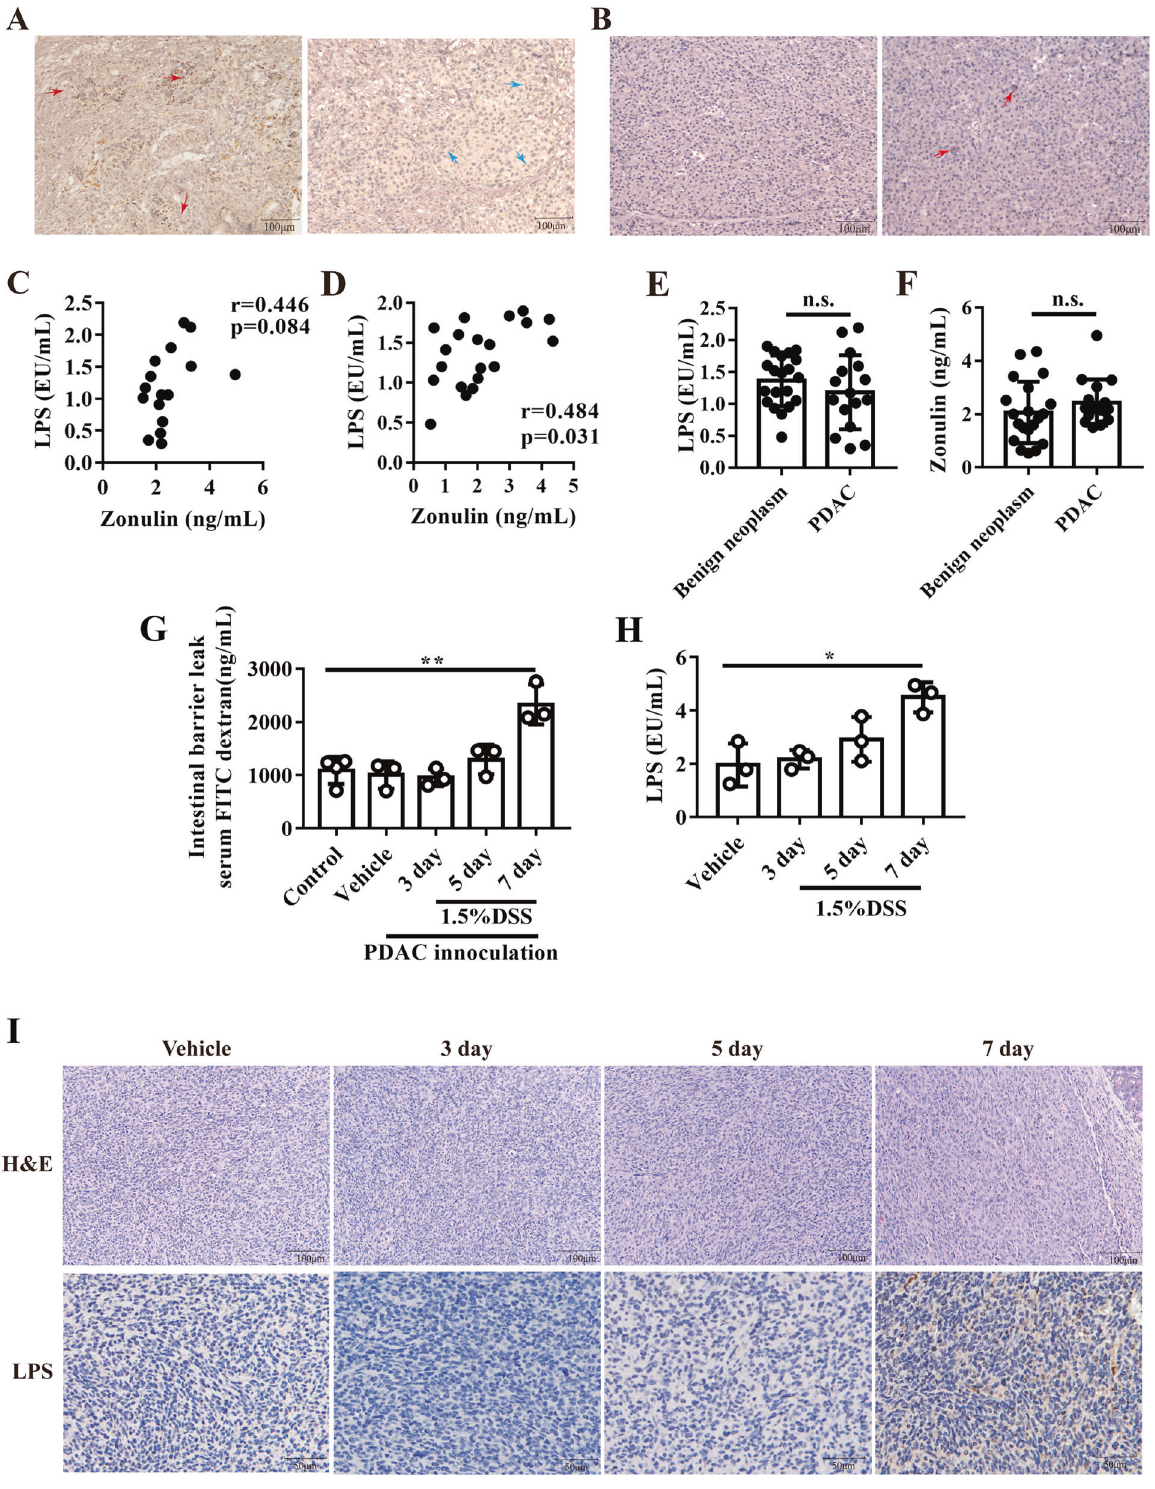
Fig. 1 LPS existed in PDAC tissue and correlated with gut leakage. A the representative images of immunochemistry staining for LPS staining in pancreatic cancer tissues. B the representative images of immunochemistry staining for LPS staining in PDAC adjacent normal tissues. The correlation between serum LPS and Zonulin in PDAC patients ( C ) or benign pancreatic neoplasm patients ( D ). The serum LPS ( E ) and zonulin level ( F ) in patients with PDAC or benign pancreatic neoplasm. G FITC conjugated dextran were used to measure intestinal leakage after DSS treatment. H mice serum LPS were measured after DSS treatment. I the typical image of HE and LPS staining in orthotopic PDAC tissue.